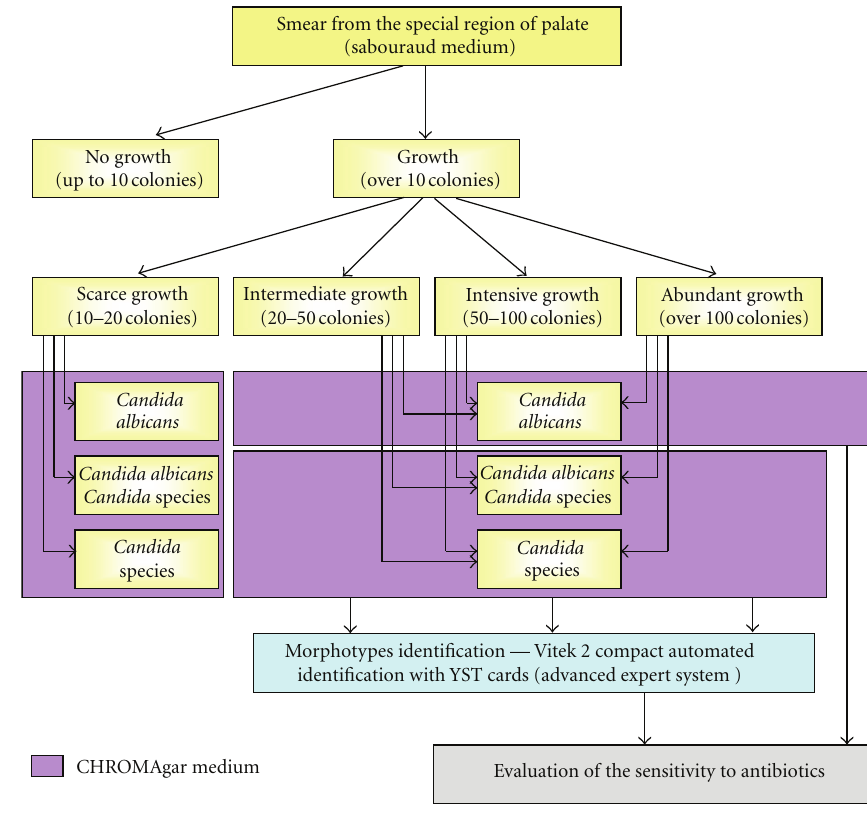
Figure 3: Diagram of microbiological procedure.